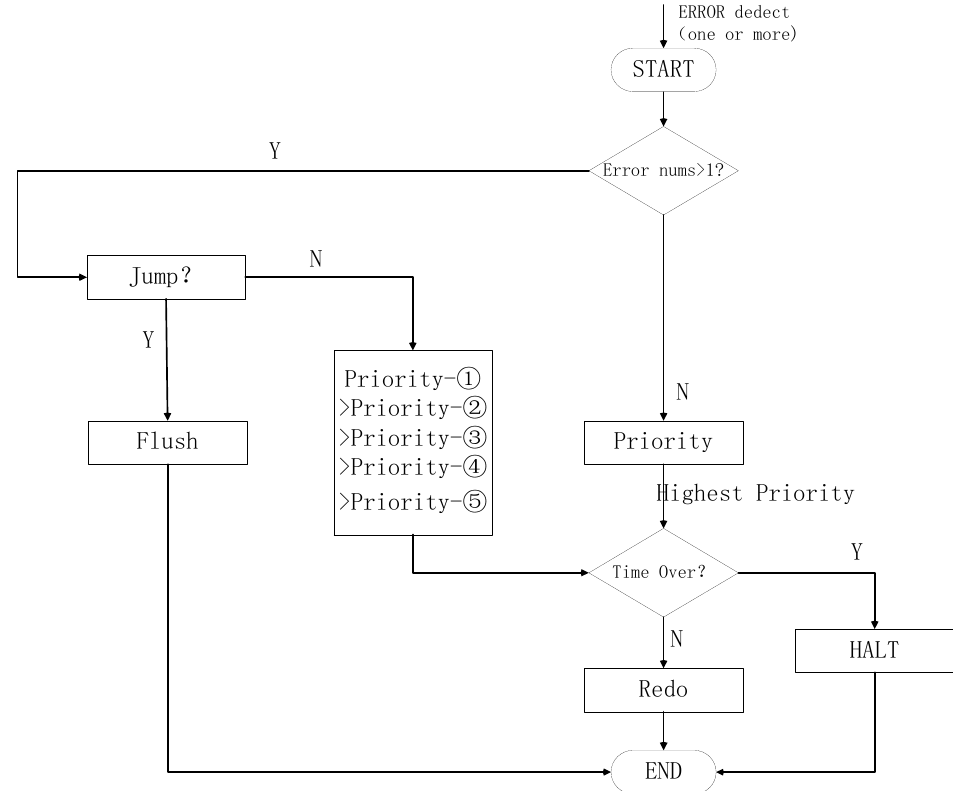
Figure 18. Flowchart of fault-tolerant rollback operation.